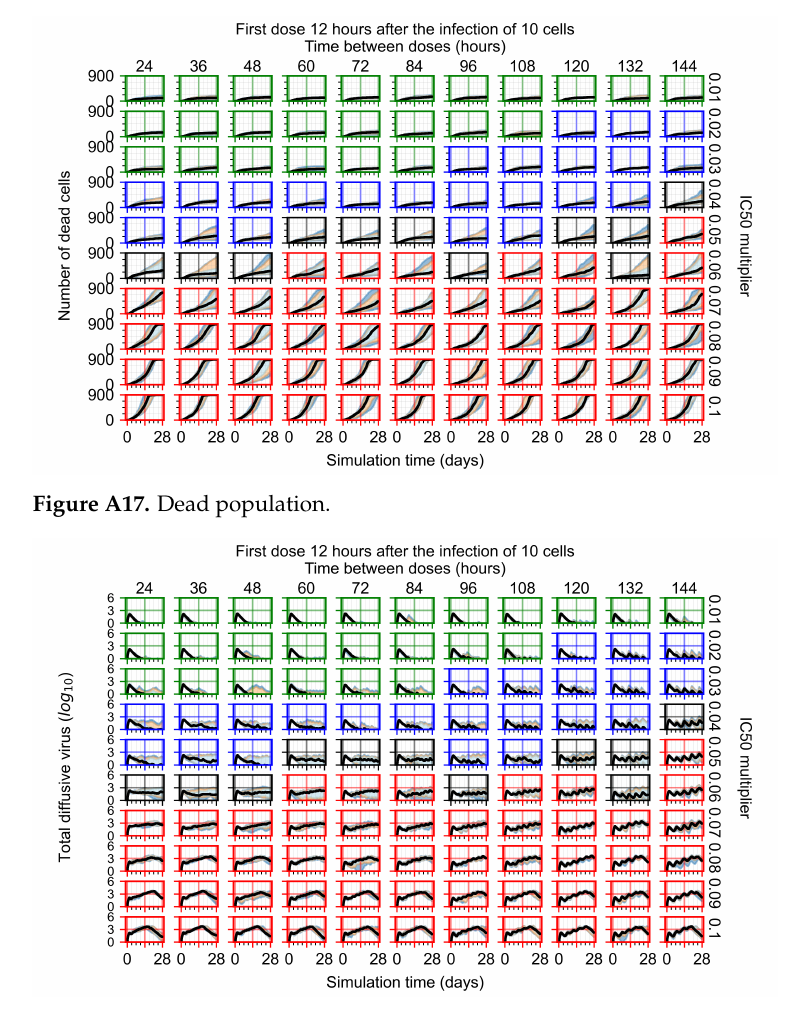
Figure A18. Extracellular diffusive virus quantities (arbitrary units), Y axis in log scale, and exponent values as tick marks.